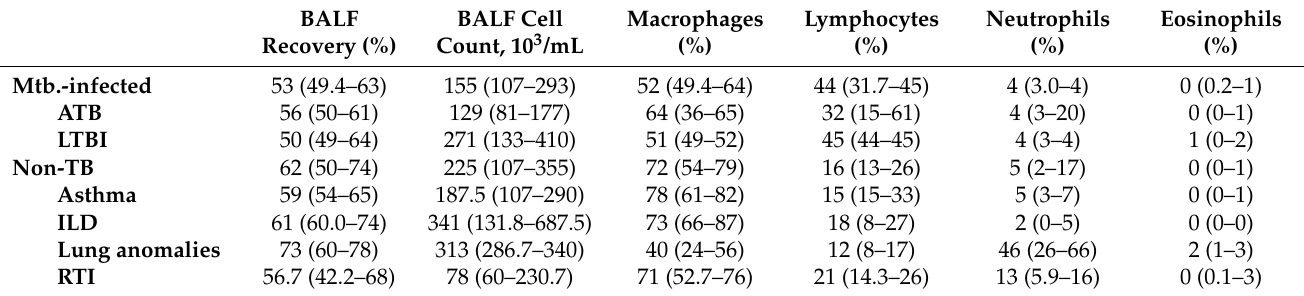
Table 2. Cytological bronchoalveolar lavage data of patients and control subjects (presented as medians and IQRs).